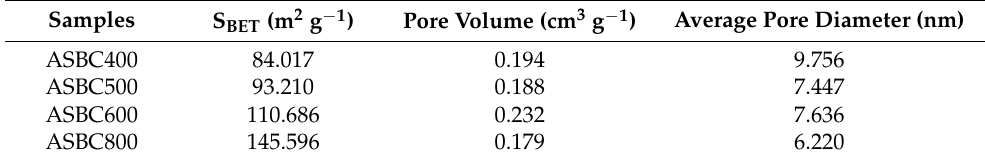
Figure 2. BET and pore size distribution of ASBC400 ( a ), ASBC500 ( b ), ASBC600 ( c ), and ASBC800 ( d ). Table 1. Basic information of ASBCx.